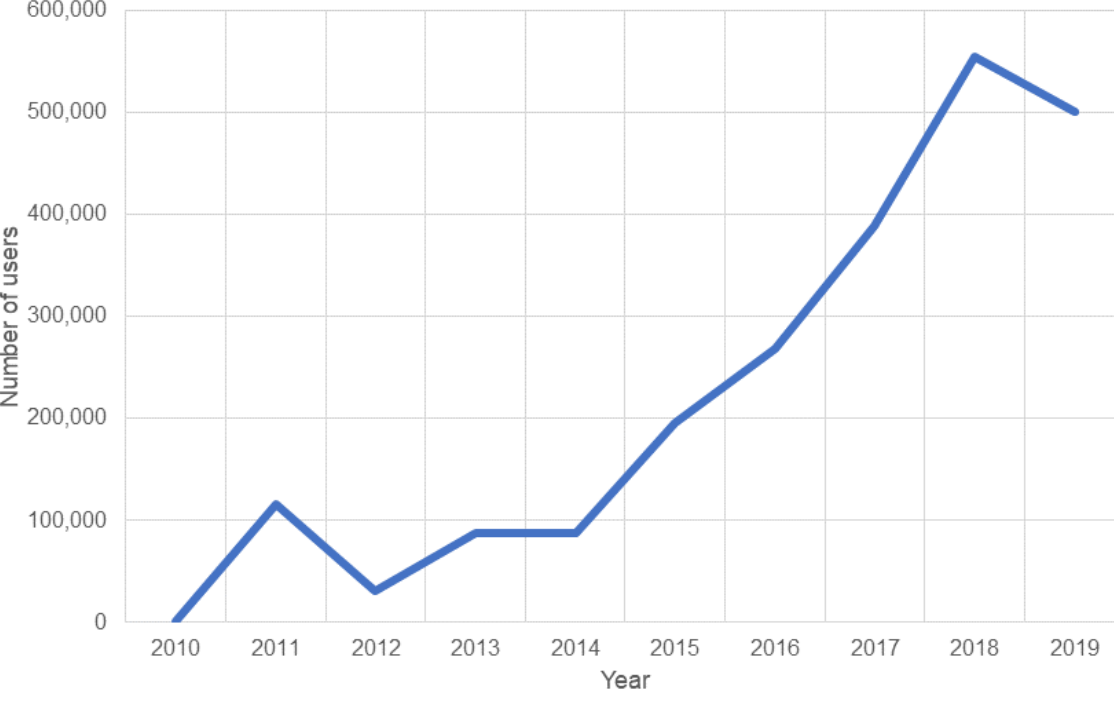
Figure 9. Total number of AIDSVu users by year,